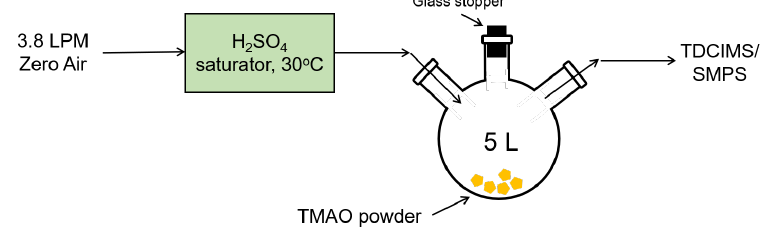
Figure 1. Particle generation setup. Generated particles were sampled directly from the reaction flask to either a nano-scanning mobility particle sizer (nano-SMPS) or the thermal desorption chemical ionization mass spectrometer